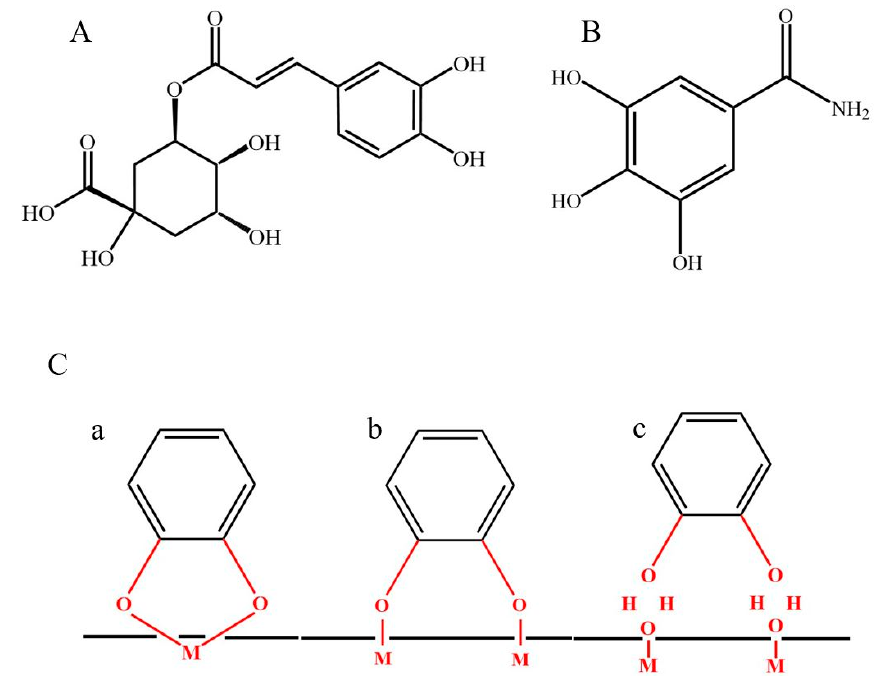
Figure 1. ( A , B ) Chemical structures of ( A ) chlorogenic acid and ( B ) 3,4,5-trihydroxybenzamide, ( C ) bonding mechanism of catechol to the metal atoms (M) on inorganic surface: ( a ) chelating, ( b ) inner sphere bridging and ( c ) outer sphere bridg-